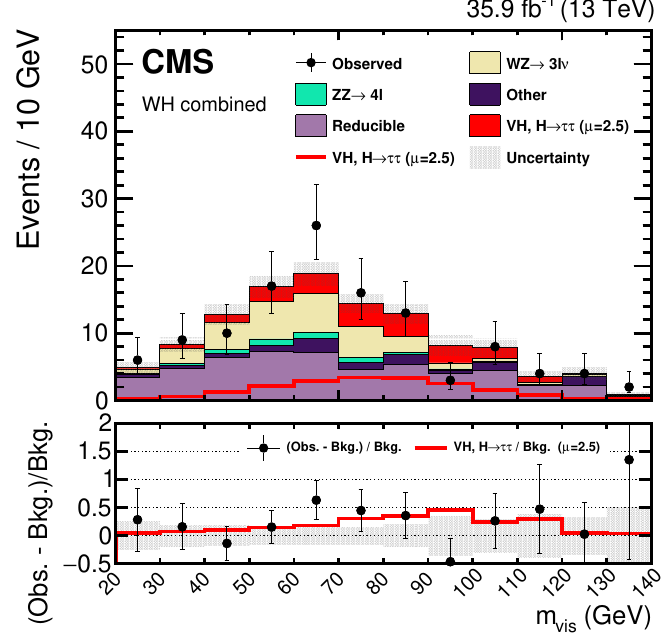
Figure 4 . Post-(cid:12)t visible mass distributions of the Higgs boson candidate in the four WH (cid:12)nal states combined together. The uncertainties include both statistical and systematic